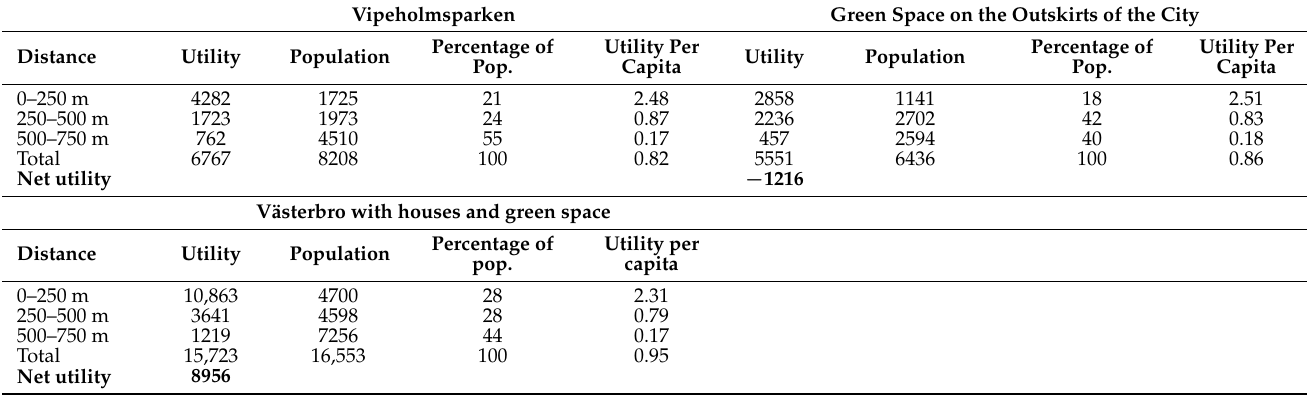
Table 4. Utility, population, utility per individual, and net utility in the three scenarios for the area on the outskirts of the city, Västerbro (offset area), and for the area around Vipeholmsparken (impact area). Vipeholmsparken Green Space on the Outskirts of the City Utility Per Percentage of Utility Per Distance Utility Population Percentage of Pop. Capita Utility Population Pop.